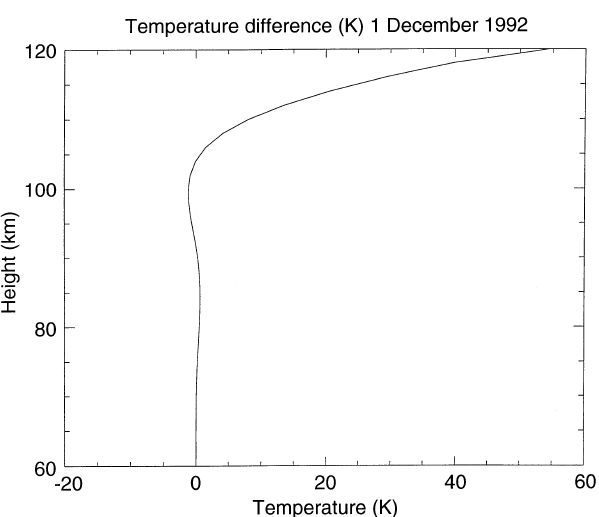
Fig. 1. An altitude profile of globally averaged temperature di(cid:128)erence (K) between solar minimum (F10.7 = 70 Wm ) 2 Hz ) 1 ) and solar maximum (F10.7 = 220 Wm ) 2 Hz ) 1 ) assuming quiet geomagnetic conditions using the MSIS 90